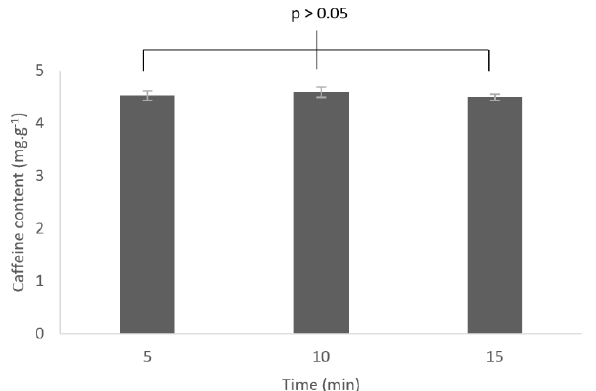
Figure 8. Influence of the time for the solid/liquid extraction of caffeine into spent coffee grounds (Experimental conditions: 2 g of SCG for 50 mL of H 2 O/EtOH (60/40), at 60 °C, magnetically stirred). All values are not significantly different ( p < 0.05) according to the Student test ( t- test).